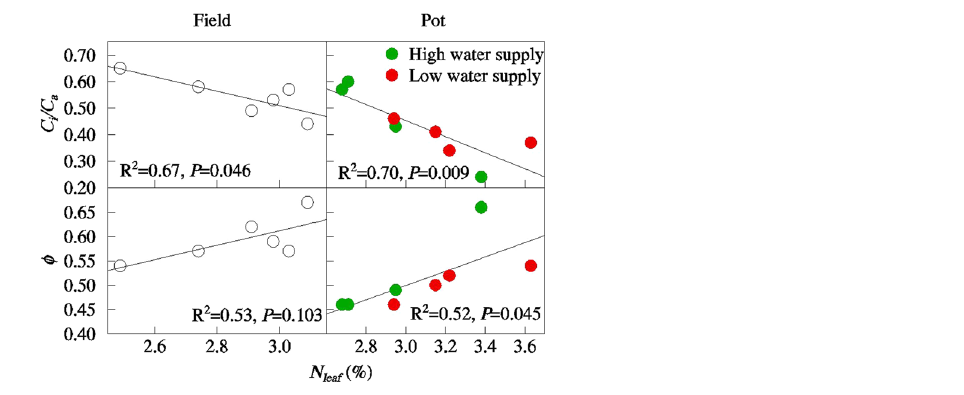
Figure 2. Relationships among leaf nitrogen concentration ( N leaf ), bundle sheath leakiness ( Ф ), and the ratio of internal and ambient CO 2 concentrations ( C i / C a ). Each data point shows the mean of samples taken from the pot experiment (N = 4) or the field experiment (N =